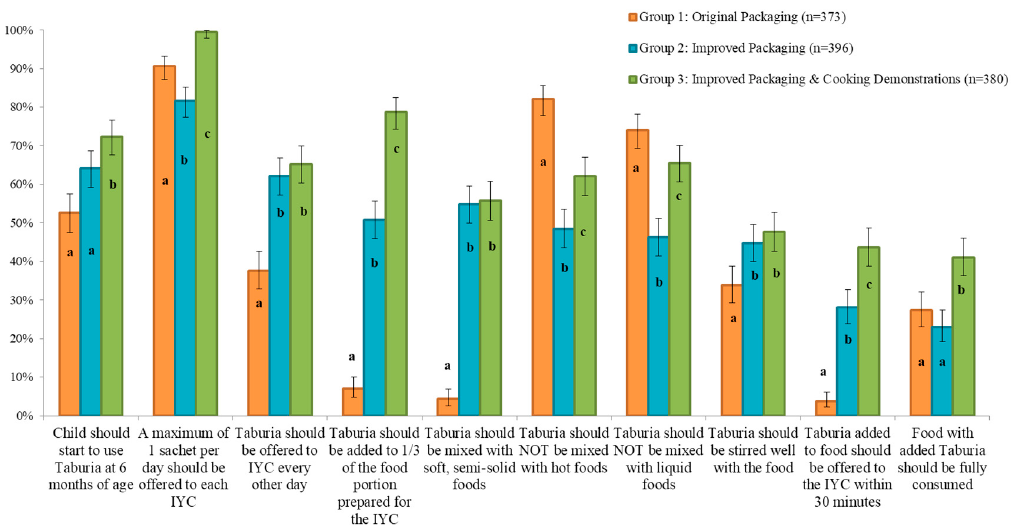
Figure 3. Caregiver knowledge regarding Taburia benefits and recommended use 30 days after distribution by study group. Group 1: Original outer packaging, as regulated by the MoH; Group 2: Improved design and messages content of outer packaging; Group 3: Improved outer packaging combined with cooking demonstrations. Error bars represent 95% confidence intervals. For all variables, differences between groups are statistically significant ( p < 0.005) using a nested design, Generalized Linear Model (GLM) applying the Binomial distribution as base distribution via a Logit link function. Within a variable, values with different superscript letters are significantly different using Wald’s Chi-square adjusted for multiple comparisons (least significant difference) post-hoc analysis ( p -value < 0.05).